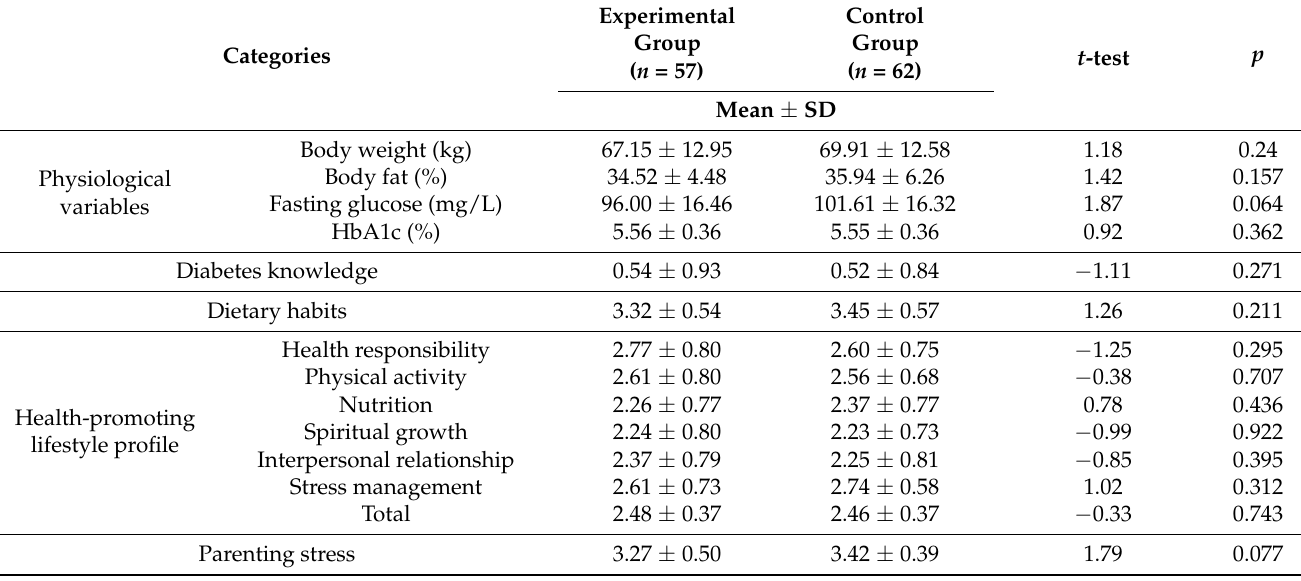
Table 2. Homogeneity test between the experimental group and the control group.